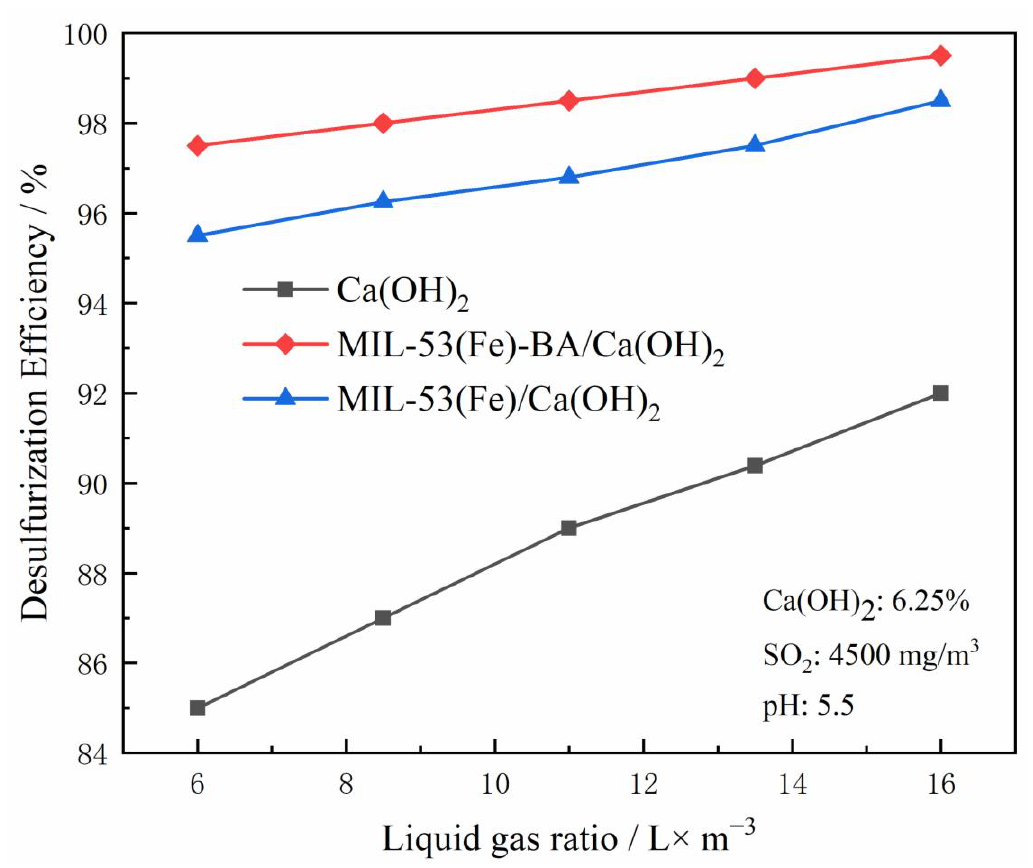
Figure 9. Effect of liquid – gas ratio on desulfurization efficiency.